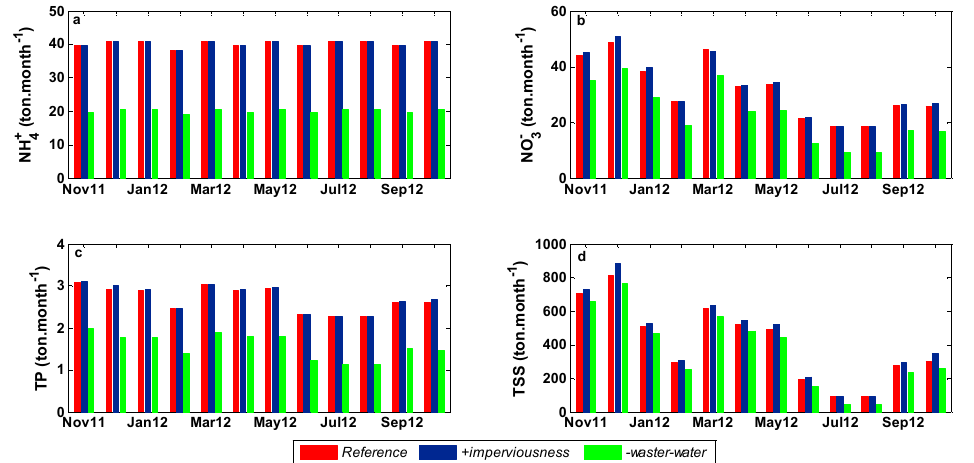
Figure 8. Monthly simulated loads of NH 4 + ( a ), NO 3 − ( b ), TP ( c ) and TSS ( d ) entering into Lake Pampulha in scenarios reference, +imperviousness and -waster_water.